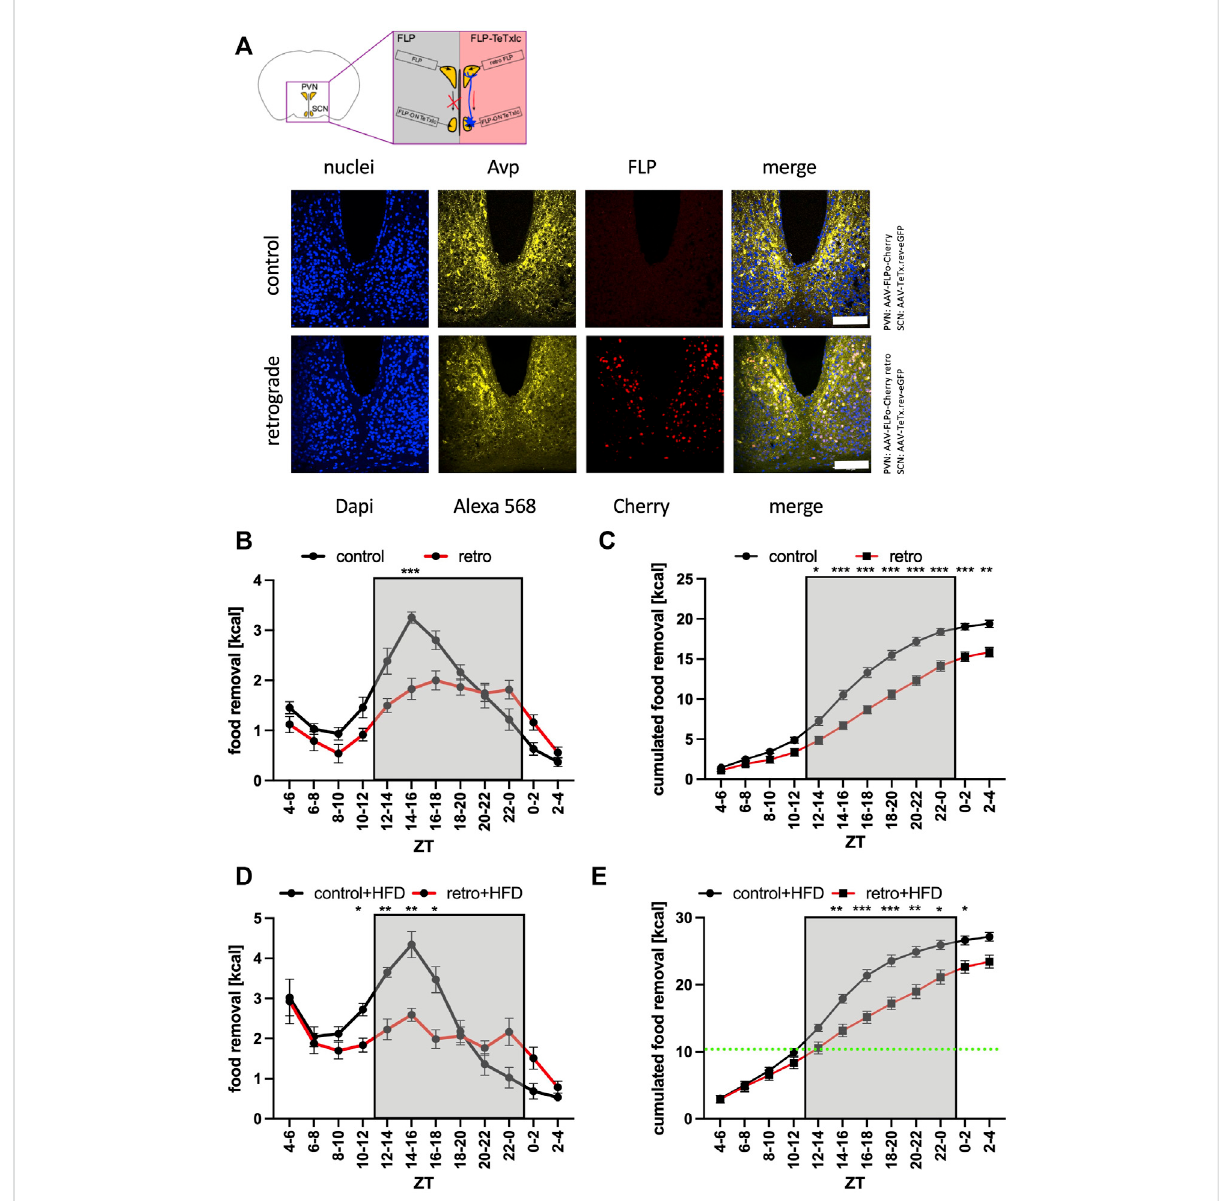
Increase of food removal during the early activity phase relies on the connection between the SCN and PVN regions. (A) Outline of the retrograde complementation assay and immuno fl uorescence staining of Avp (Alexa 568, yellow) and detection of Cherry (red). ×40 objective (numerical aperture = 1.3, oil), a white bar measures 100 μ m. (B) Food removal in each 2 h bin starting from ZT4-6 for FLP delivered with AAV-9 (control, black) or FLP delivered with AAV-R (retro, red) into both PVN regions, and TeTxlc injected into both SCN regions (2-way repeated measure ANOVA, N = 12, p < 0.001, F = 23.48, DFn = 1, DFd = 22). (C) Accumulation of food removal over the course of the experiment 5B (2-way repeated measure ANOVA, N = 12, p < 0.001, F = 30.06, DFn = 1, DFd = 22). (D) Food removal in each 2 h bin starting from ZT4-6 for FLP delivered withAAV-9(control,black)orFLPdeliveredwithAAV-R(retro,red)intobothPVNregions(2-wayrepeatedmeasureANOVA,N=12, p < 0.01,F=8.21, DFn = 1, DFd = 22). (E) Accumulation of food removal over the course of the experiment 5D (2-way repeated measure ANOVA, N = 12, p = 0.05, F = 4.18, DFn = 1, DFd = 22). To correct for multiple testing, the Š idák ’ s post hoc test was employed; *: p < 0.05; **: p < 0.01; ***: p < 0.001. Shown is the mean ±